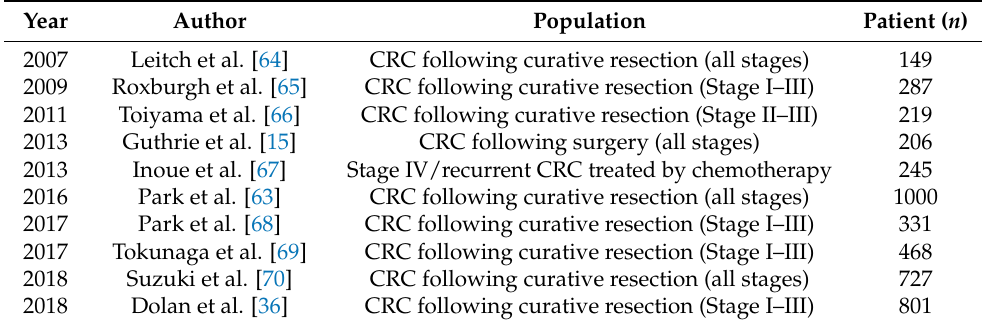
Table 3. Modified Glasgow prognostic scale (mGPS) in previous